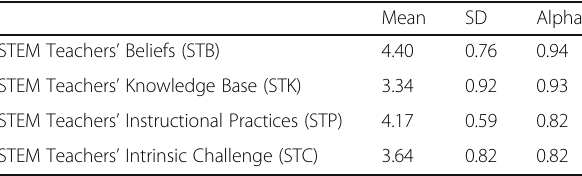
Table 4 Correlation coefficients for variable pairs ( n = 216) Mean